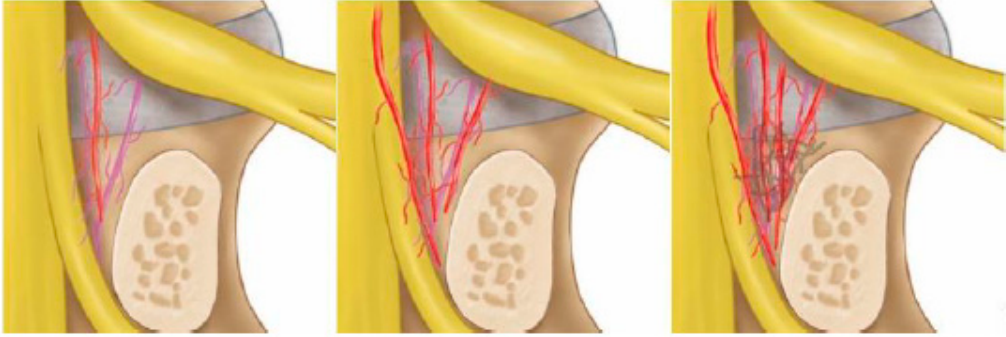
Figure 8. Drawings of the neovascularization grading system. Left picture showing a grade 1 normal appearance with sparse epidural vessels around the disc. The middle picture showed a grade 2 increased neovascularization of epidural vessels with vascularization. The right picture showed grade 3 with increased neovascularization of epidural vessels with vascularization and adhesion on neural tissues.